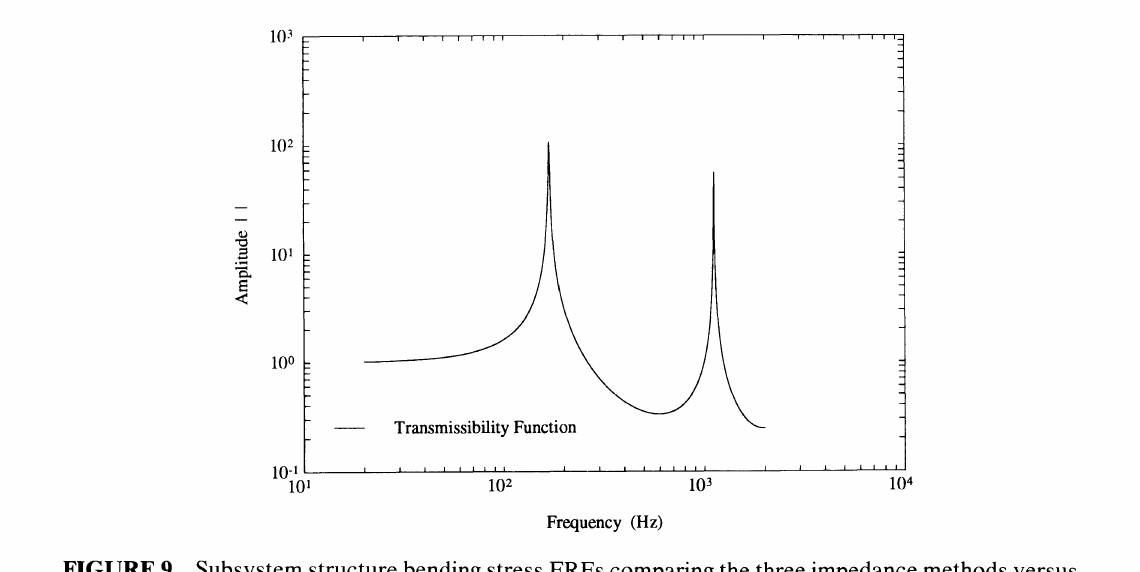
FIGURE 9 Subsystem structure bending stress FRFs comparing the three impedance methods versus field levels and an infinite impedance